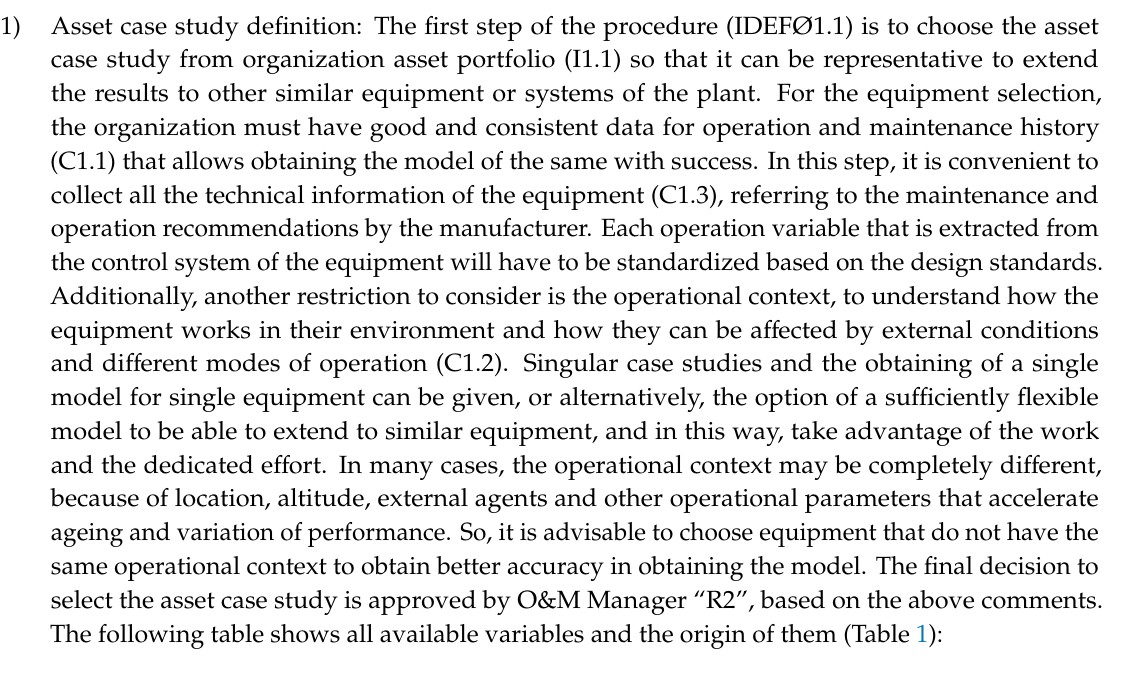
Table 1. Asset case study definition, data source, for the process pump